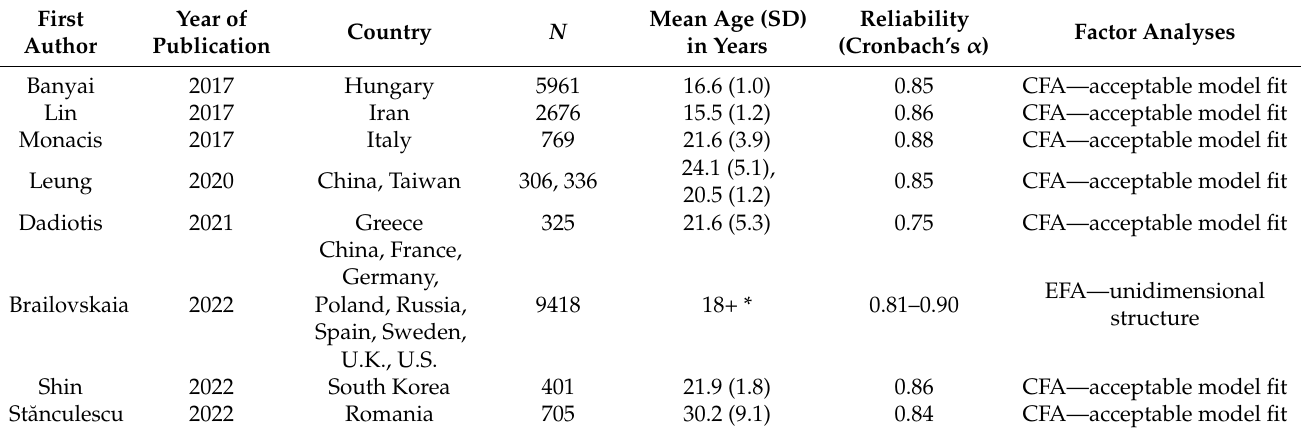
Table 1. Studies evaluating psychometric properties of Bergen Social Media Addiction